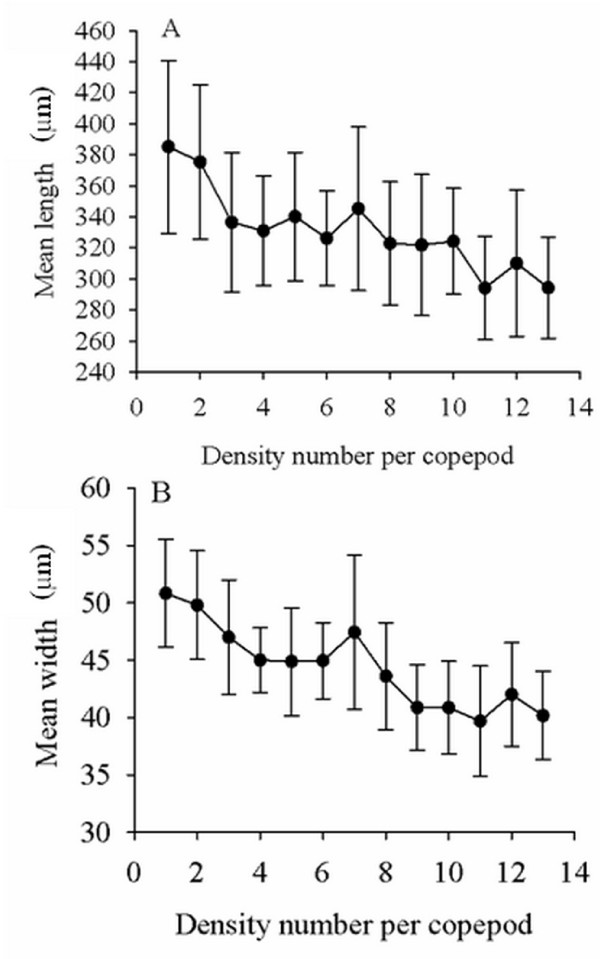
Relationship of worm size and density per copepod. The relationship of worm size and density per copepod: A, length; B, width.